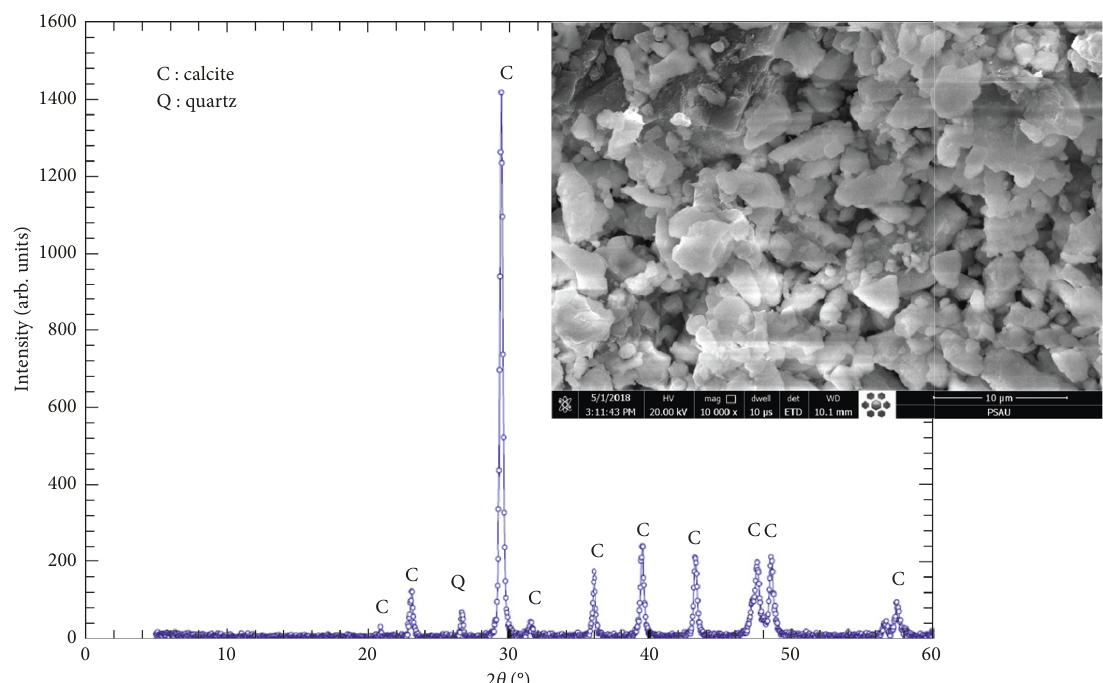
Figure 8: SEM micrographs and XRD patterns of marble powder